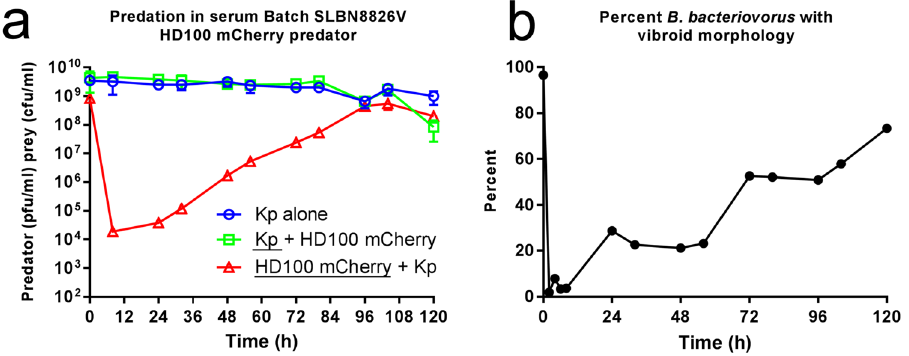
Figure 8. ( a ) Predation in whole human serum by HD100 mCherry fluorescent predator. Changes in the population of both K. pneumoniae prey (Kp + HD100 mCherry) and B. bacteriovorus HD100 mCherry predator (HD100 mCherry + Kp) were enumerated periodically during the predation assay. As a control, K. pneumoniae prey suspended in serum was enumerated periodically in the absence of B. bacteriovorus HD100 mCherry predator (Kp alone). (b) Microscopic analysis of B. bacteriovorus morphology in human serum with K. pneumoniae prey. MicrobeJ software was used to automatically detect mCherry tagged fluorescent B. bacteriovorus cells and measure the roundness ( 4 × area / ( π × major axis 2 ) of each individual cell at each time point. A roundness cut off of 0.65 was selected to distinguish between cells with typical vibroid morphology (roundness score < 0.65) and those with an abnormal round morphology (roundness score ≥ 0.65).